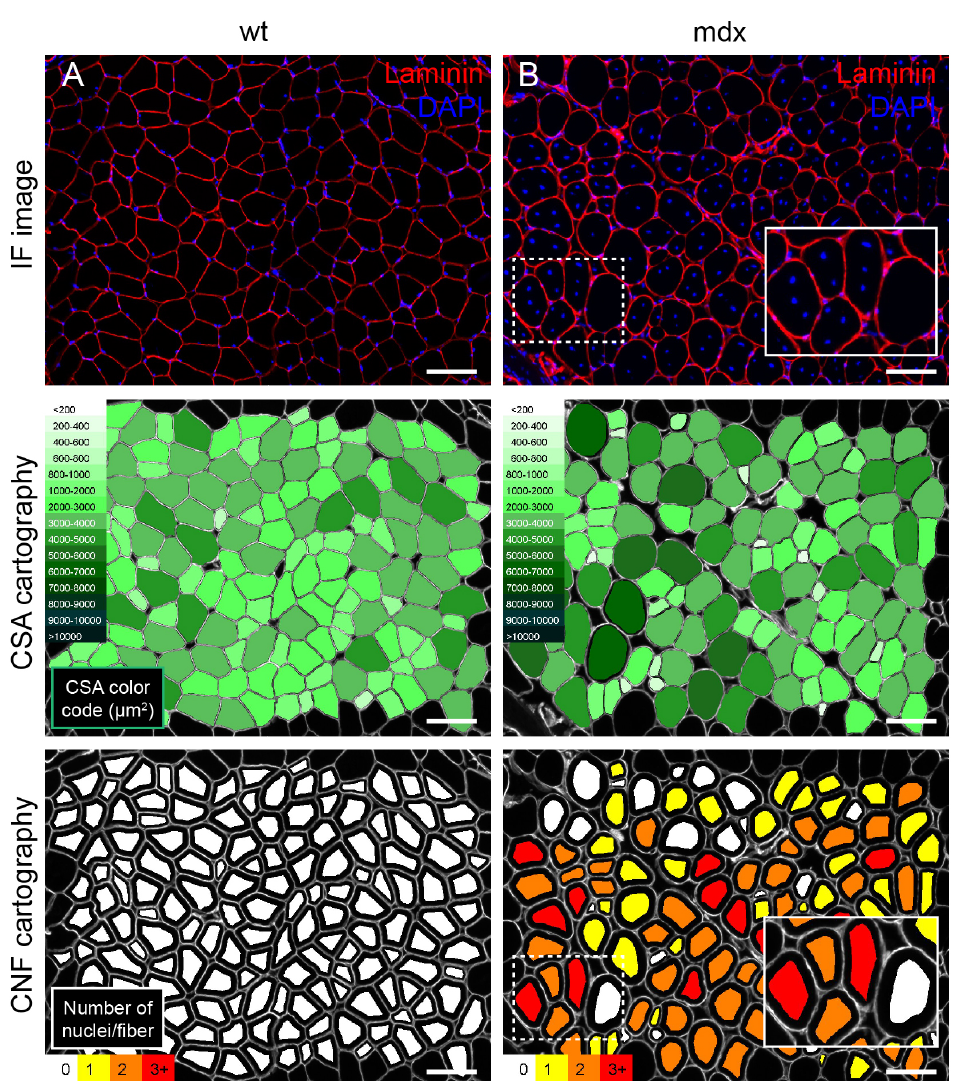
Figure 3. Morphological analysis of the muscle fibres of a wild type vs. an mdx mouse. ( A ) Repre- sentative image of the quadriceps of a wild type (WT) C57BL/10SCSNJ mouse. The periphery of the myofibres was labelled using an antibody against laminin (red) and nuclei were stained with DAPI (blue) as in [63]. ( B ) Representative image of the same muscle of a C57BL/10SCSN-Dmdmdx J mouse with the same staining. Below both images, the corresponding fibre cross sectional area (CSA) cartography automatically obtained after the analysis of the images shown in A and B with the program MuscleJ ([55], see Table S1). The green-scale colour code indicates the myofibre CSA in µ m 2 . This program also quantifies centrally nucleated fibres (CNFs) and the number of nuclei per fibre. At the bottom of the figure, the automatically obtained cartography shows a colour code depending on the number of central nuclei quantified in each fibre (white for 0, yellow for 1, orange for 2 and red for 3 or more nuclei). Note that mdx muscle samples are characterised by an irregular distribution of fibre CSA and high numbers of CNFs. Scales: 100 µ